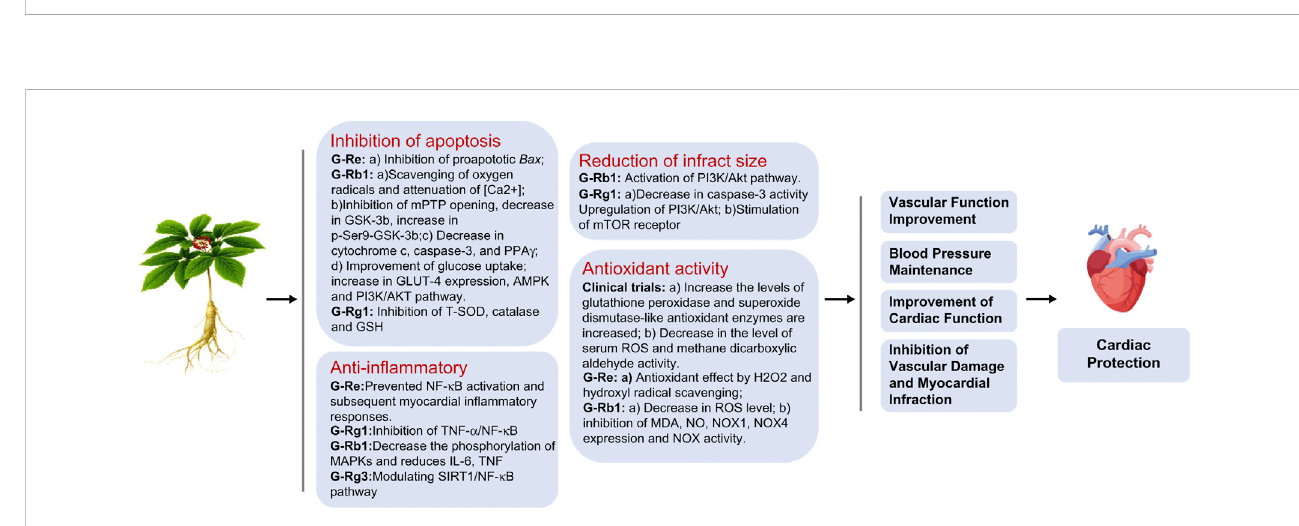
FIGURE 7 Ginseng ’ s cardiac protection